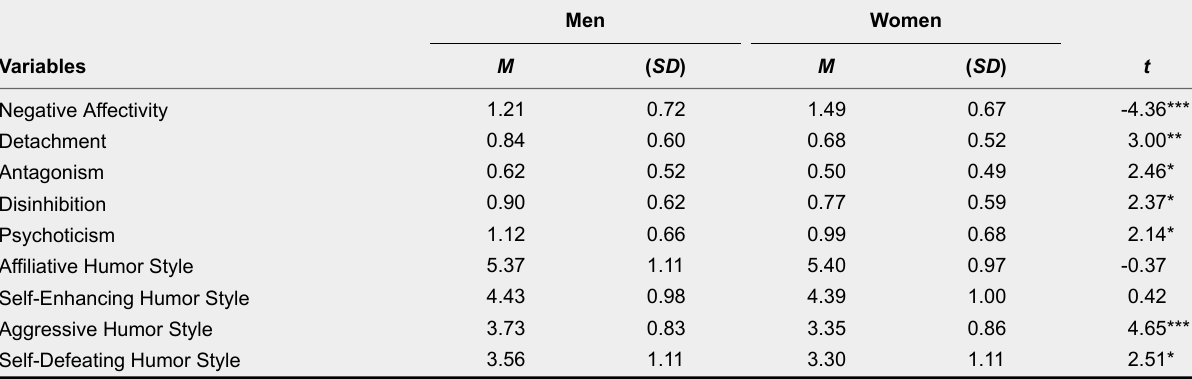
Sex Differences for Pathological Personality Traits and Humor